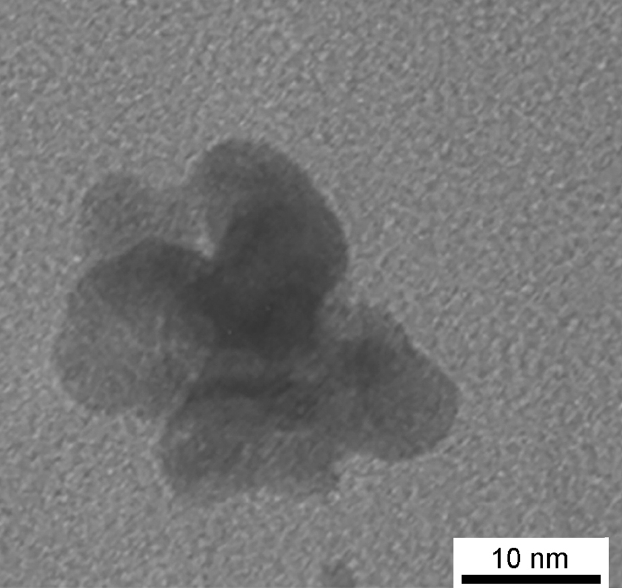
Figure 8. Micrographs of gold nanoparticles in PMAA/AuNPs composite film. Electrolyte 3. Libra- 200FE transmission electron microscope, Carl Zeiss (Germany).